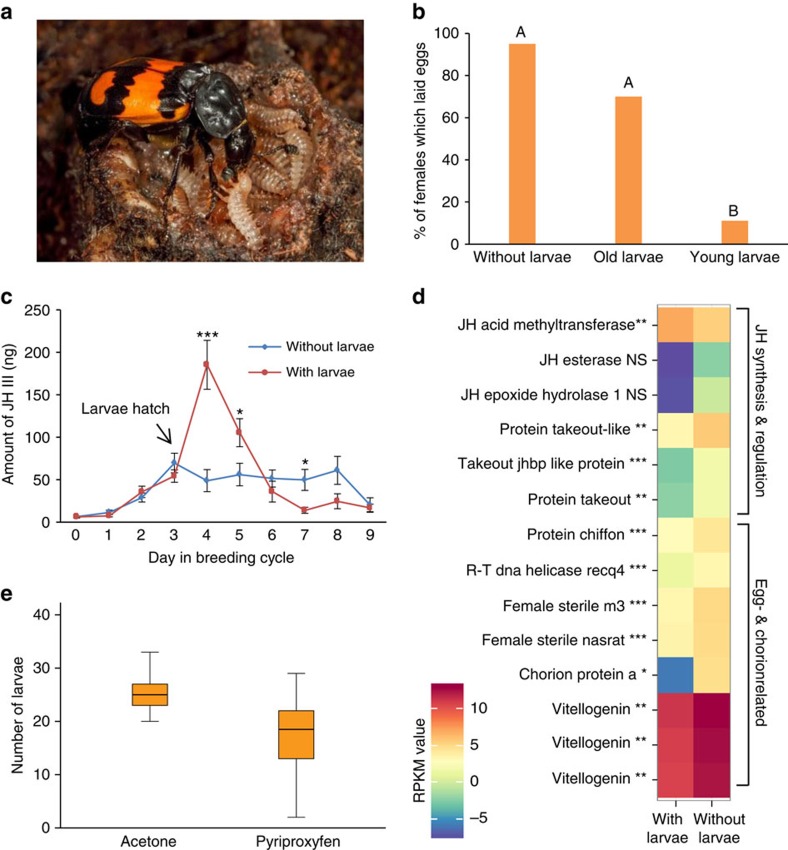
Offspring production and JH III.(a) Female N. vespilloides feeding a larva (reproduced with permission from the author, Heiko Bellmann). (b) Percentage of mothers laying eggs. Mothers were either denied access to their larvae after hatching (without larvae) or were caring for young needy larvae (young larvae) or older nutritionally independent larvae (old larvae). Different letters represent significant differences between groups at P<0.05 (χ2-test following Benjamini–Hochberg; N=18-20). (c) JH III profile in ng per individual (mean±s.e.) over an entire breeding cycle. Females were either allowed to care for their larvae (with larvae; N=191) or withheld from their hatched larvae (without larvae; N=186). There was an interaction effect of treatment group and day (Gaussian GLM: F9,357=9.91, P<0.0001). Note: on day 3 larvae hatched, but had not yet arrived on the carcass. (*P<0.05, **P<0.01, ***P<0.001). (d) Expression patterns of genes (heatmap based on geometric means) related to JH III biosynthesis/regulation and ovarian activity of females caring for larvae (day 4 in the breeding cycle) and females who were withheld from their larvae on hatching (day 4 in the breeding cycle; for each group N=3). Transcript abundances are expressed as log2 transformed normalized values (RPKM). (Student's t-test following Benjamini–Hochberg; *P<0.05, **P<0.01, ***P<0.001). (e) Number of larvae produced by females treated with pyriproxyfen or acetone (control). Boxplots show median, interquartile range, minimum/maximum range; N=19, Poisson GLM: Wald-=18.34, P<0.0001.